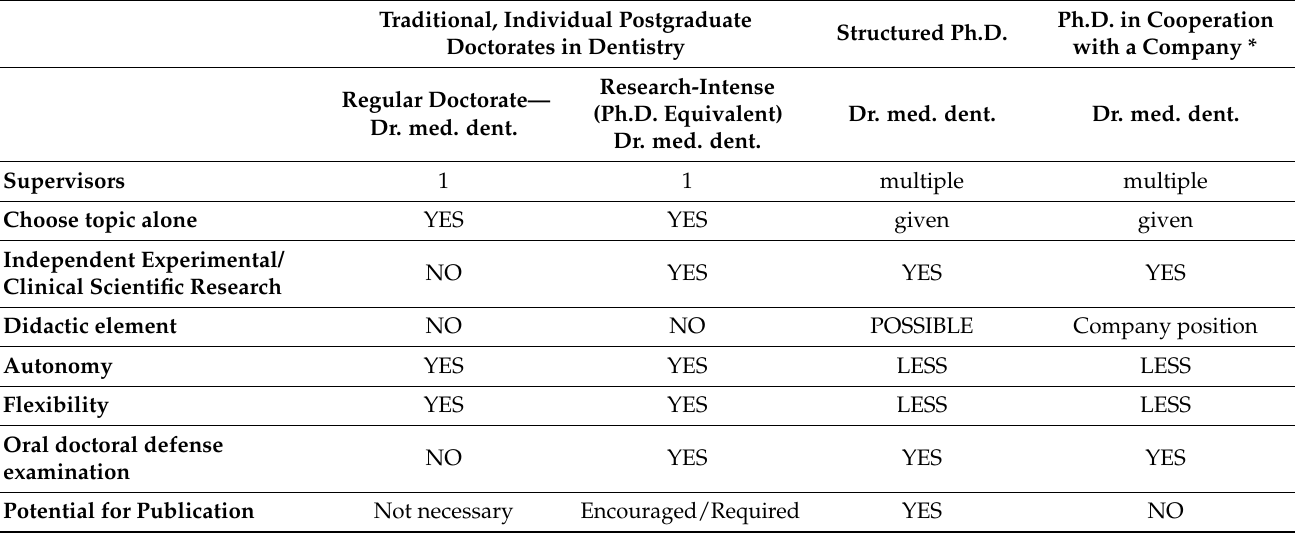
Table 3. Differences and similarities between all four different doctorate types in Germany related to postgraduate medical and dental doctorates. * This type is rarely seen in medicine/dentistry. Traditional, Individual